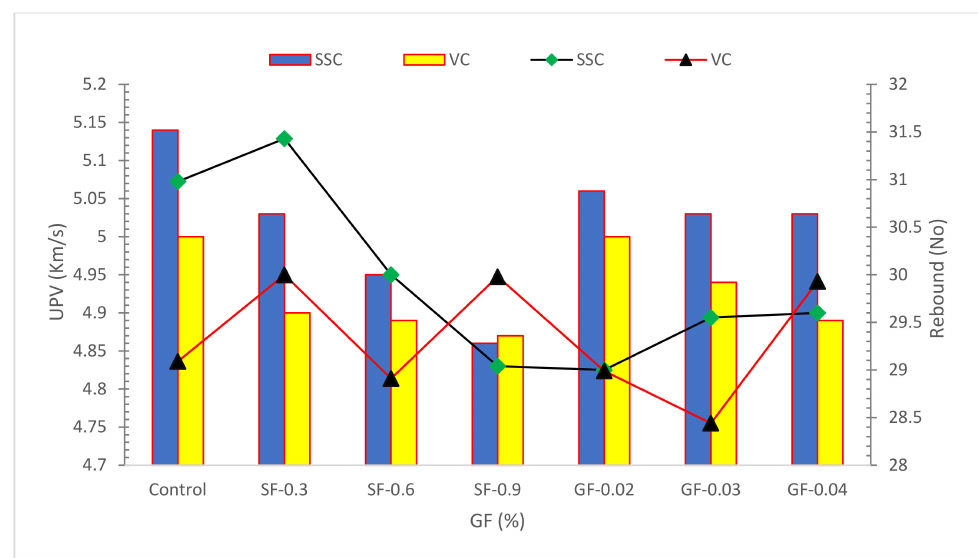
Figure 11. UPV and Rebound Hammer Test Results: Data Source